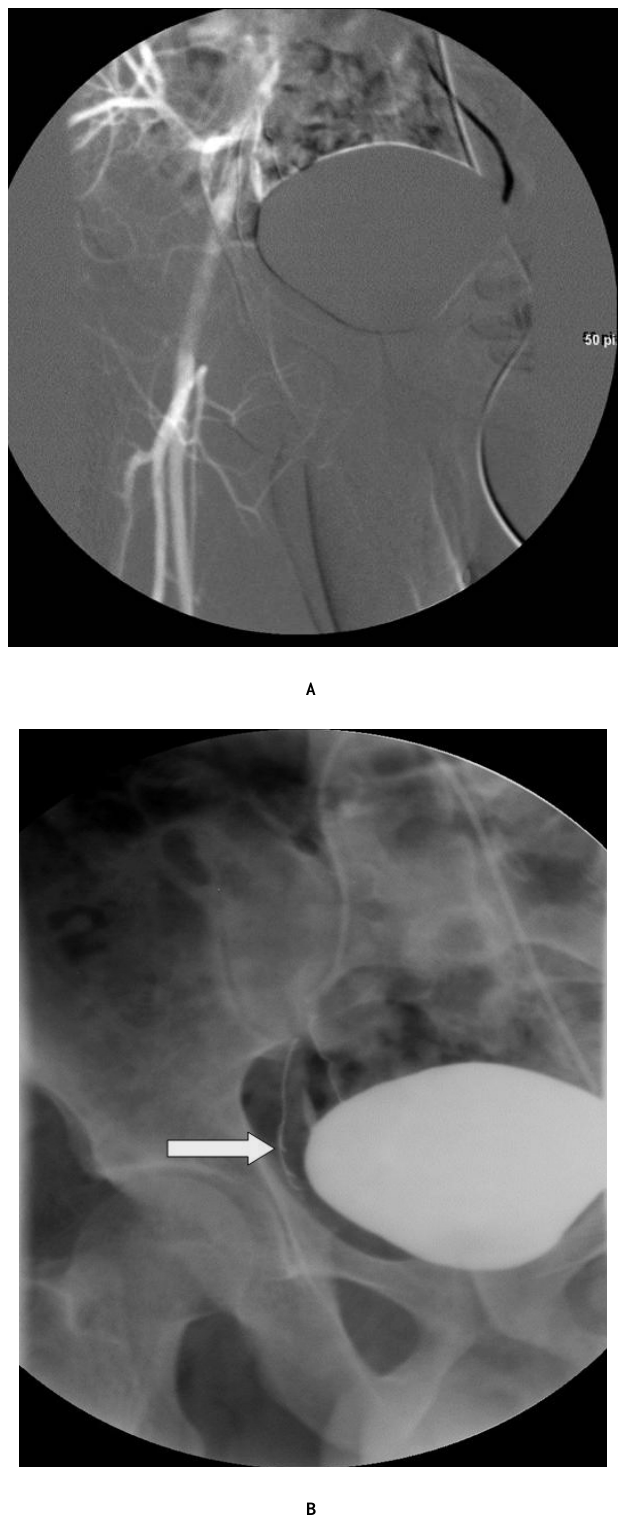
FIGURE 4. (A) Postembolization subtraction arteriogram showed complete closure of the lesion. (B) plain X-ray of the pelvis showing evidence of the platinum microcoils (arrow) in